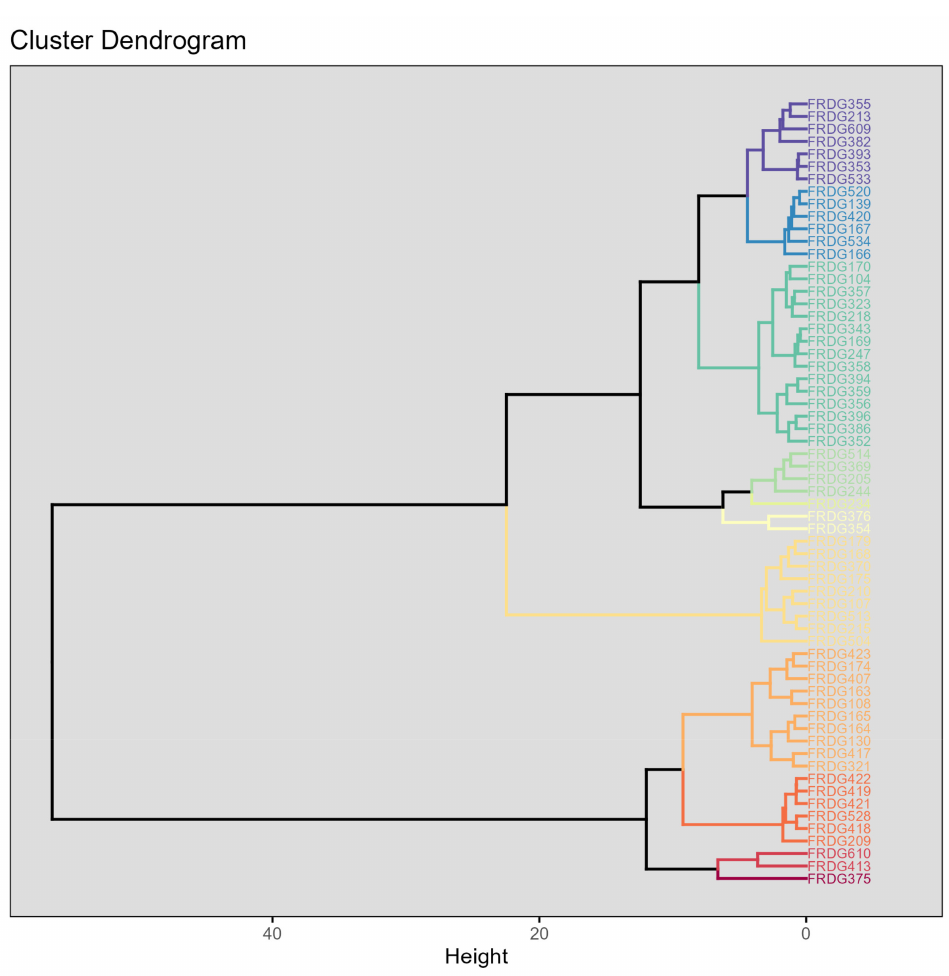
Figure 5. Cluster dendrogram of all groundwater bodies resulting from the agglomerative hierarchical clustering (AHC). FRDGx is an acronym used to represent the French reference of groundwater bodies, where “FR” stands for French reference, “D” refers to the Rh ô ne-M é diterran é e Basin, “G” indicates the groundwater body, and “x” signifies the identification code of the particular groundwater body. The colors of each cluster in this dendrogram are reported on Figure